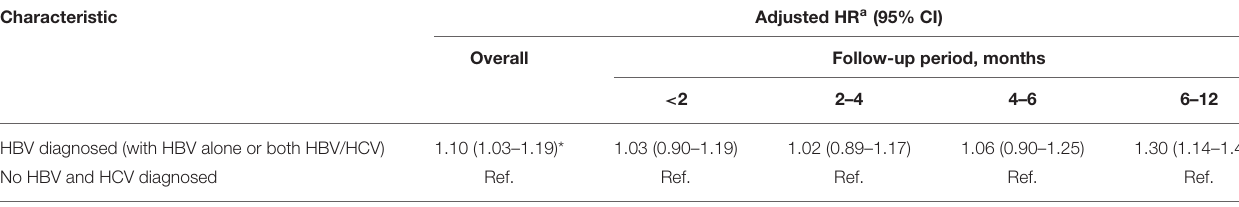
TABLE 3 | Risk of follow-up period mortality in HCC patients receiving sorafenib with or without HBV/HCV. Characteristic